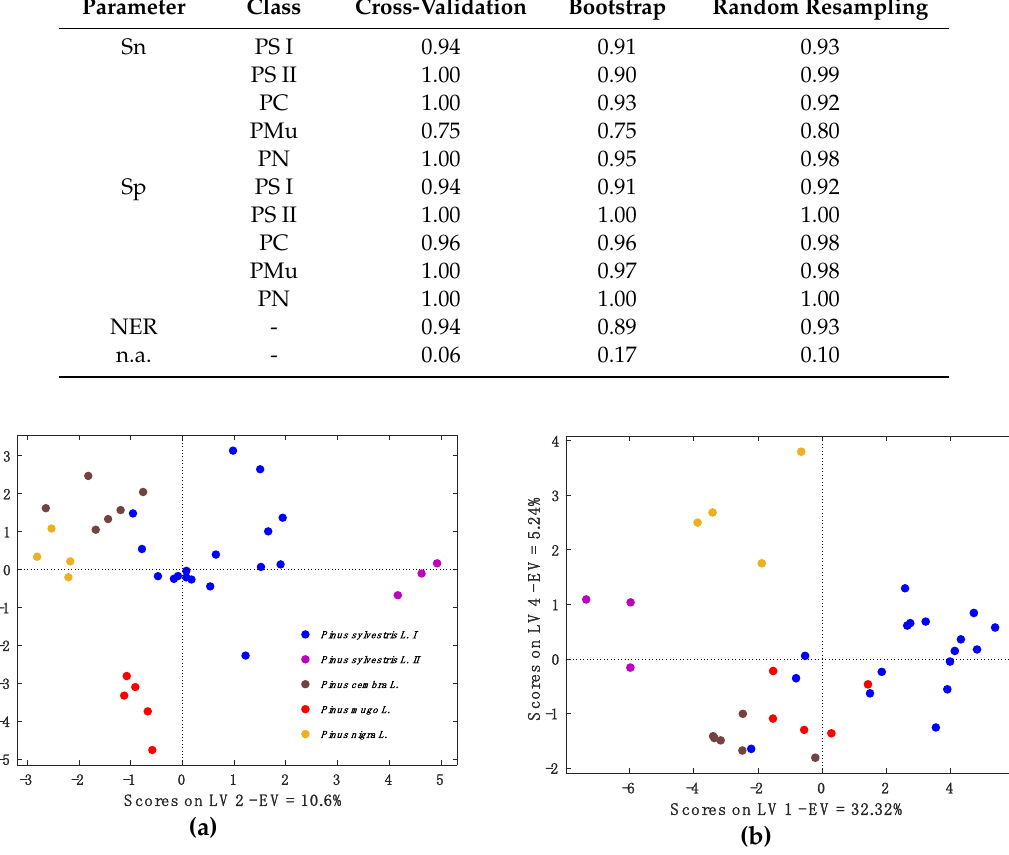
Figure 5. ( a ) The score plot of LV2 to LV3. ( b ) The score plot of LV1 to LV4.